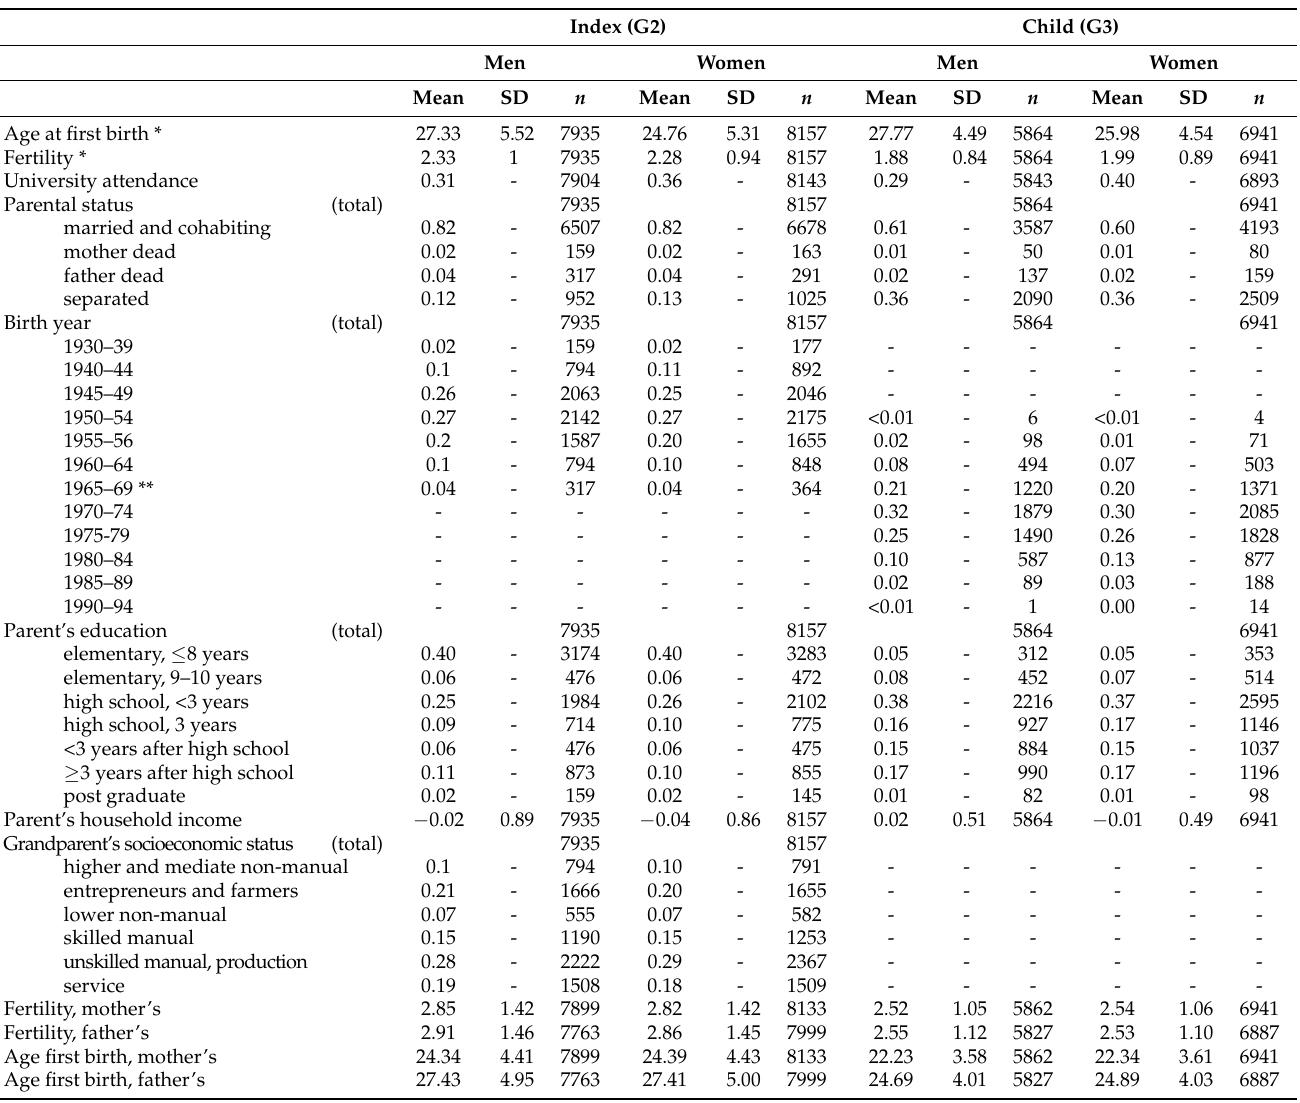
Table 1. Descriptive statistics for all variables by cohort and gender. For clarity, standard deviations are omitted for categorical variables and means refer to proportion of individuals within that category. NB: many in the child generation had not completed